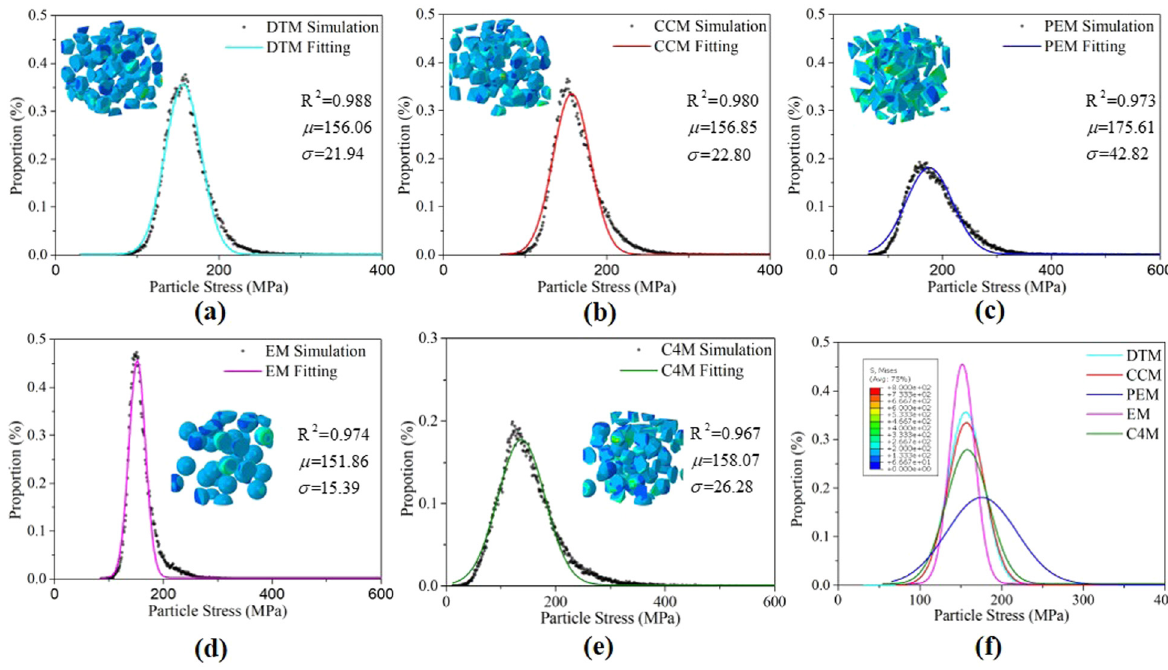
Figure 8: Particle micro - stress distribution at a 0.1% strain: ( a ) DTM, ( b ) CCM, ( c ) PEM, ( d ) EM, ( e ) C4M, and ( f ) fi tting